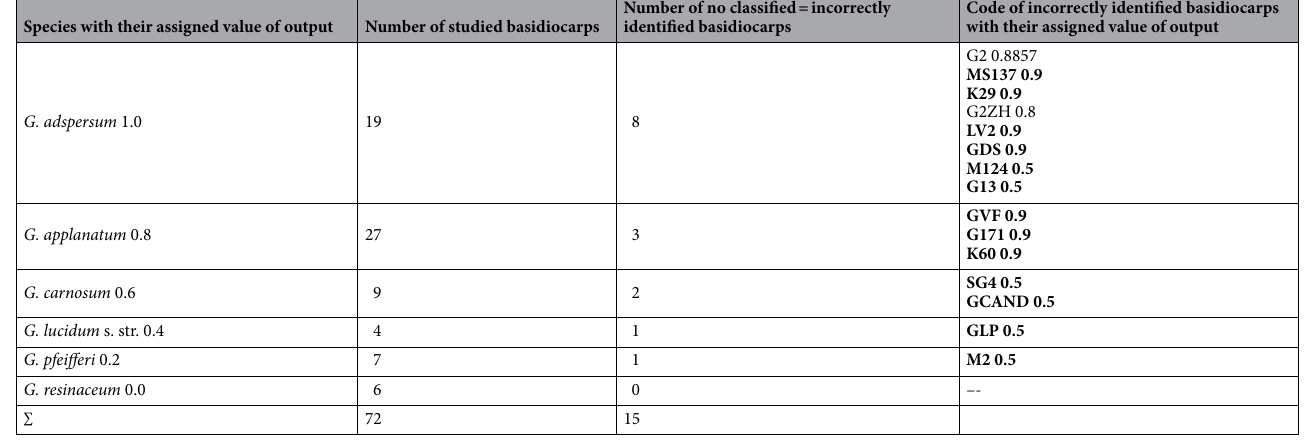
Table 6. Ganoderma basidiocarps processed by FIS